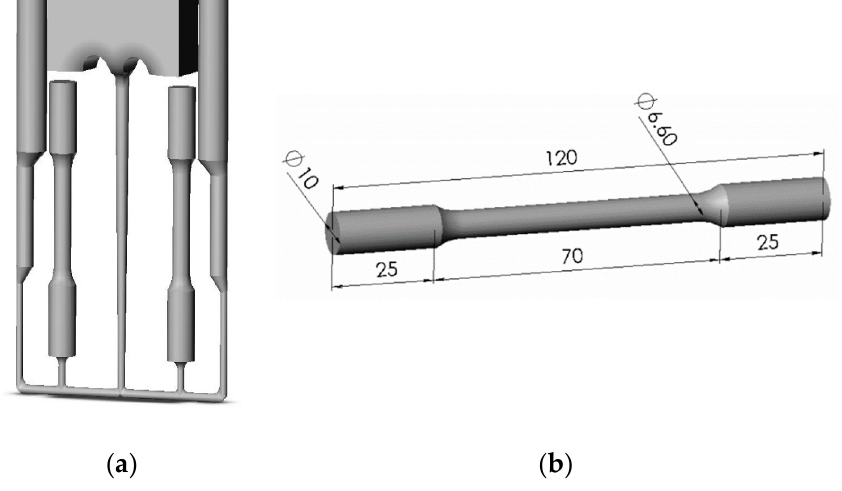
Figure 2. ( a ) The schematic representation of the tensile test mould design and ( b ) the dimension of test bars (in mm).